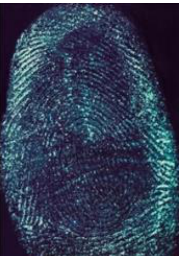
Figure 7. Fingermark developed by G-CDs on water-immersed substrate.